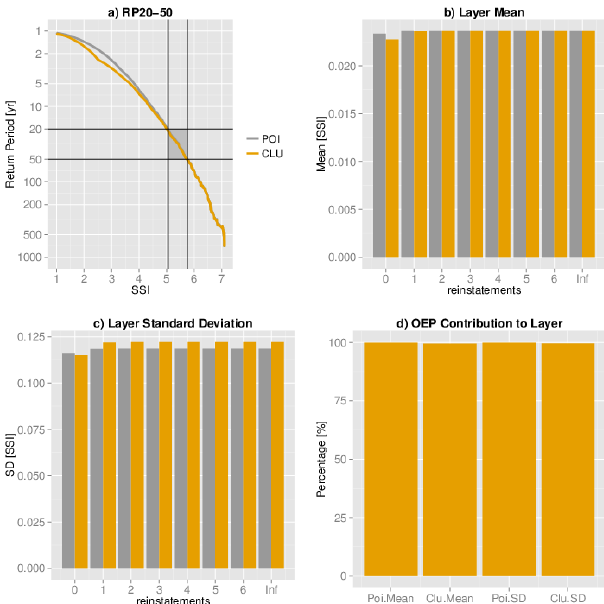
Figure 4. The upper left panel depicts the OEP curves for the Pois- son (POI) and clustered (CLU) models of the data. The vertical and horizontal lines on the upper left panel depict the SSI (loss) and return period thresholds of the attachment and exhaustion point of the catXL layer under consideration (note that the SSI values are the same as in Fig. 2 which are labelled as SSI250). The attachment and exhaustion points are consistent with the 2- and 20-year return periods derived off the Poisson OEP curve. The mean loss to layer as a function of the number of re-instatements is shown in the upper right panel. The lower left panel depicts the standard deviation of the annual aggregate loss to layer as a function of the number of re-instatements. The lower right panel depicts the percentage con- tribution of the first annual maximum loss to the catXL mean and standard deviation of the loss for the case of zero re-instatements.